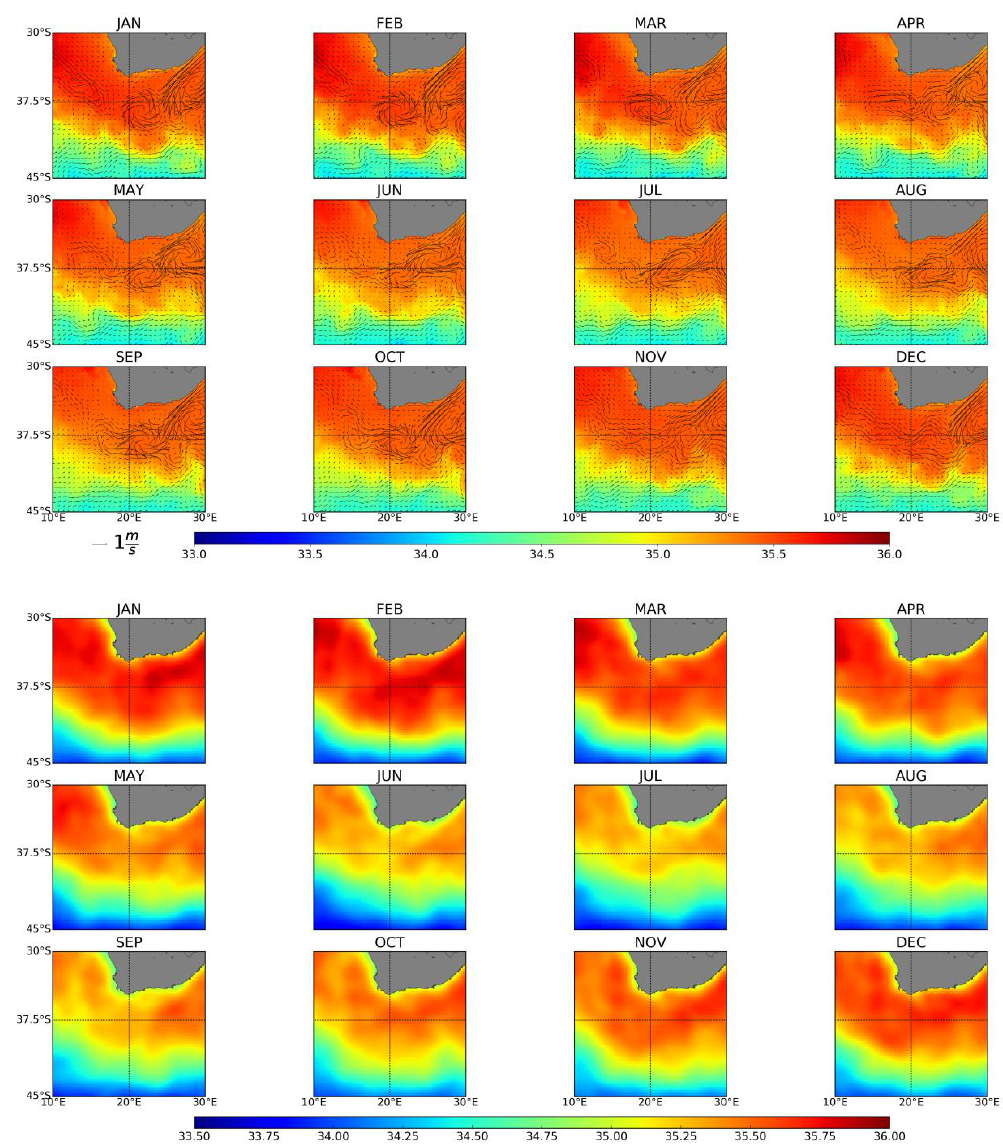
Figure 4. As in Figure 2 but for the Figure 4. A s in Figure 2 but for the AL.